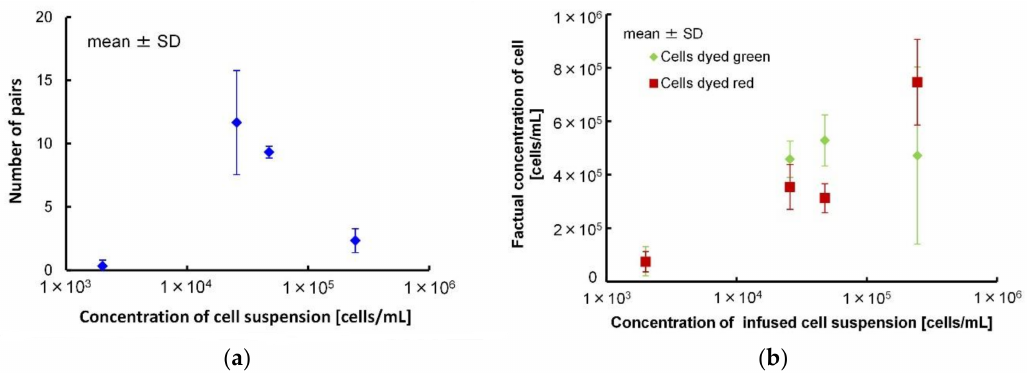
Figure 6. ( a ) Relationship between concentration of cell suspension and number of cell pairs formed in the microchannel by applying an AC voltage. ( b ) Relationship between concentration of cell and liposome suspension and concentration of introduced cells.